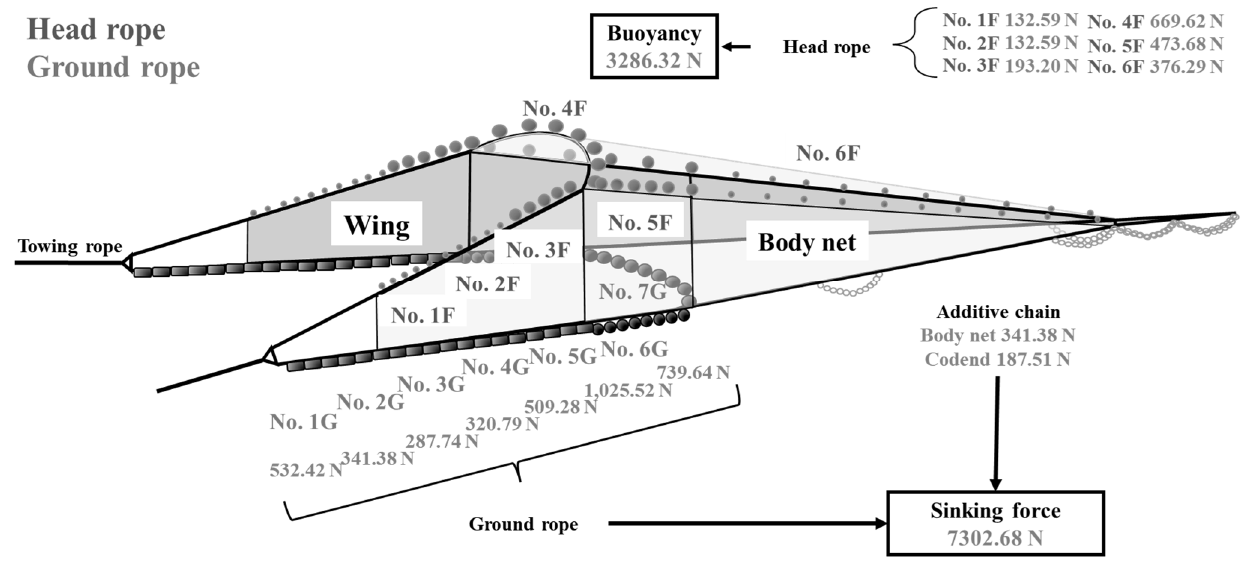
Figure 10. A typical pair trawl fishery gear setup. Conventional design of pair trawl fishery gear had 744.64 kg of sinking force and 335.10 kg of buoyancy. In float parts, only sphere-shaped floats were arranged in a conventional design.